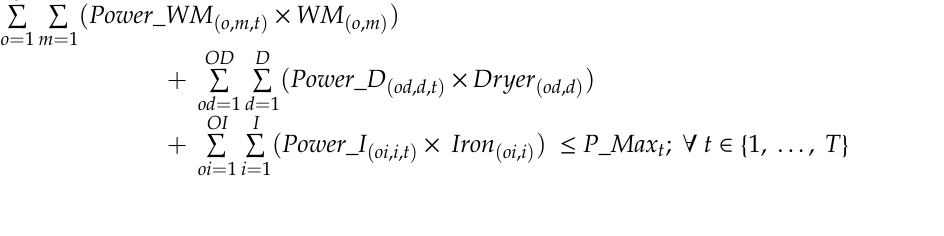
Table 3. Definition of parameters in (5), (6), and